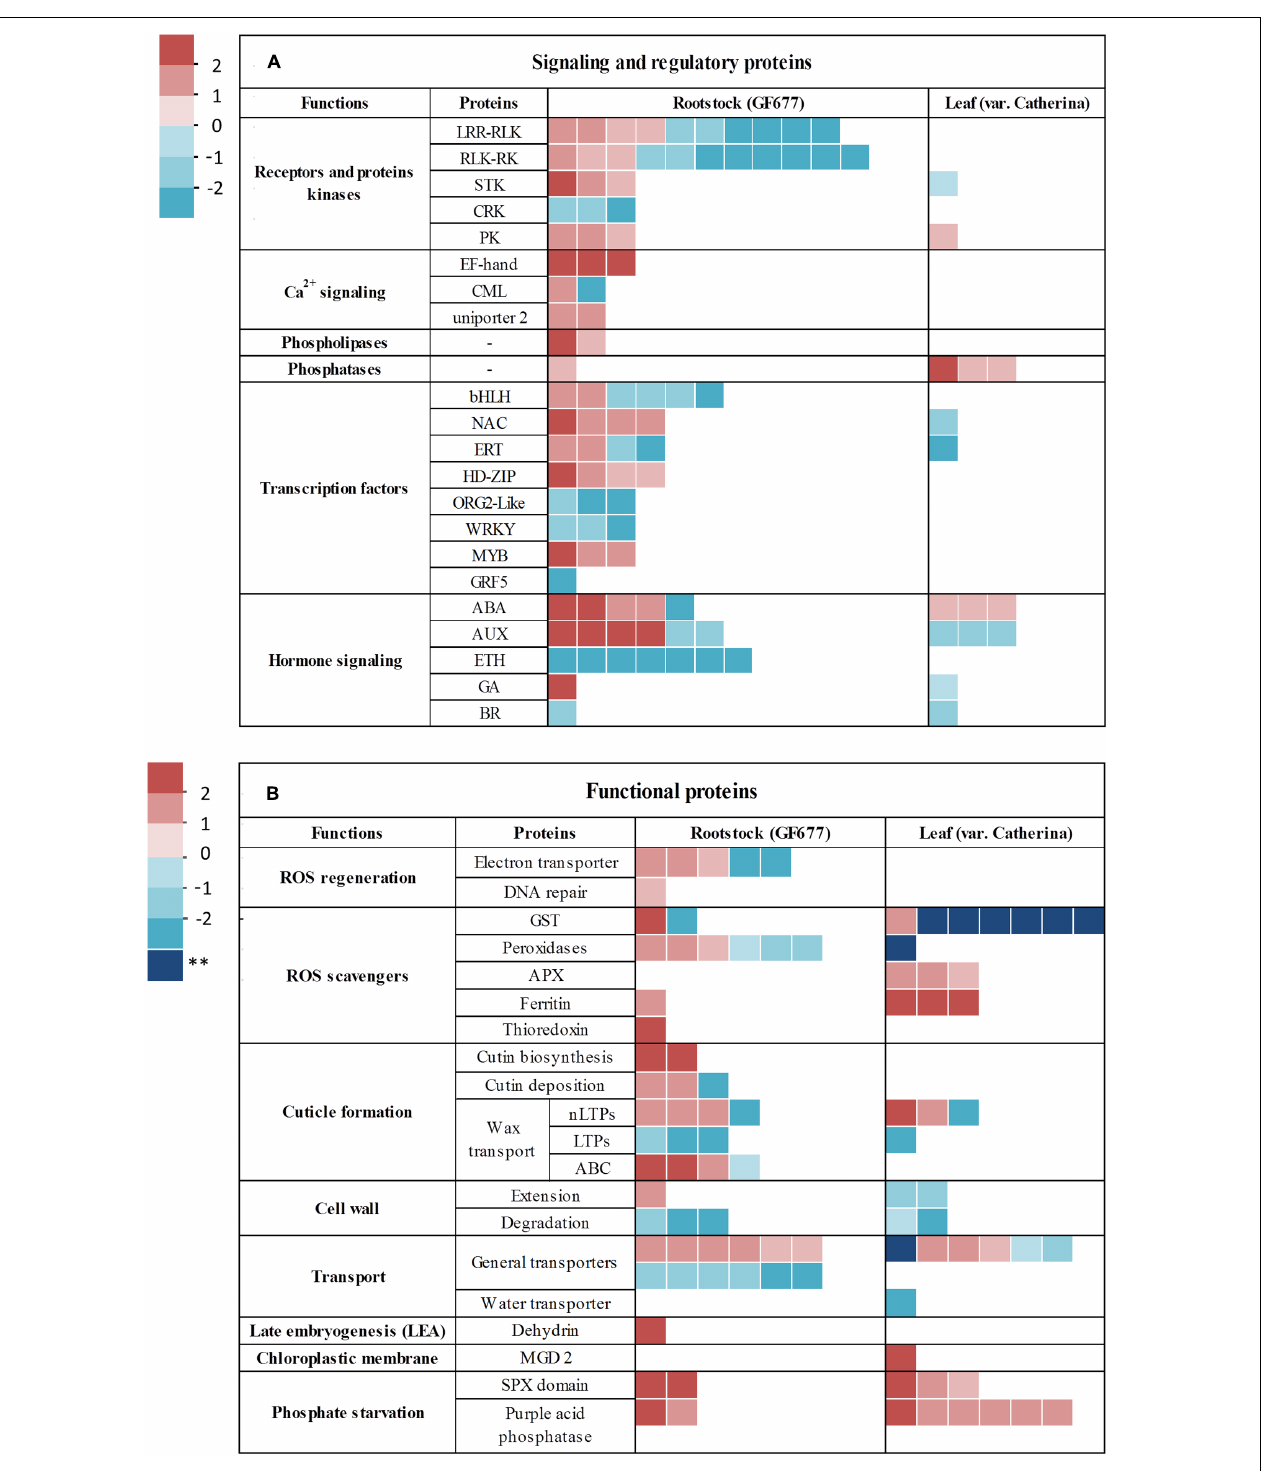
FIGURE 5 | Levels of expression of DEGs identified in roots (GF677 rootstock) and leaves (graft, var. Catherina). (A) DEGs involved in signaling and regulatory processes. (B) DEGs involved in functional processes. Details are provided in Supplementary Table S3. The scale bar on the left represents the observed changes in expression in terms of Log 2 FC from upregulation (red squares) to downregulation (blue squares). The dark blue pattern with stars indicates genes uniquely expressed in leaves in the control group. The fold change was calculated as the ratio between the drought-stressed and control plants. ERT, ethylene-responsive transcription factor; GRF5, growth-regulating factor 5; ABA, abscisic acid; ETH, ethylene; AUX, auxin; GA, gibberellin; BR, brassinosteroid; APX, ascorbate peroxidase; nLTPs, non-specific-lipid transfer proteins; LTPs, lipid transfer proteins; ABC, ATP-binding cassette.